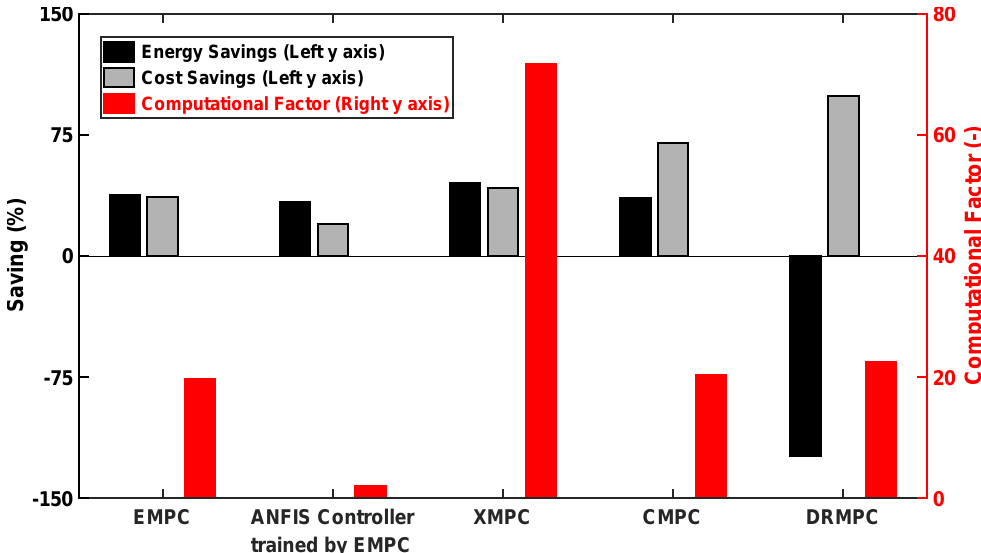
Figure 22. Summary of optimal controllers performance, compared to the rule-based controller for the sample day in Figure 19. Computational factor is calculated as the computational time of the controller divided by the computational time of